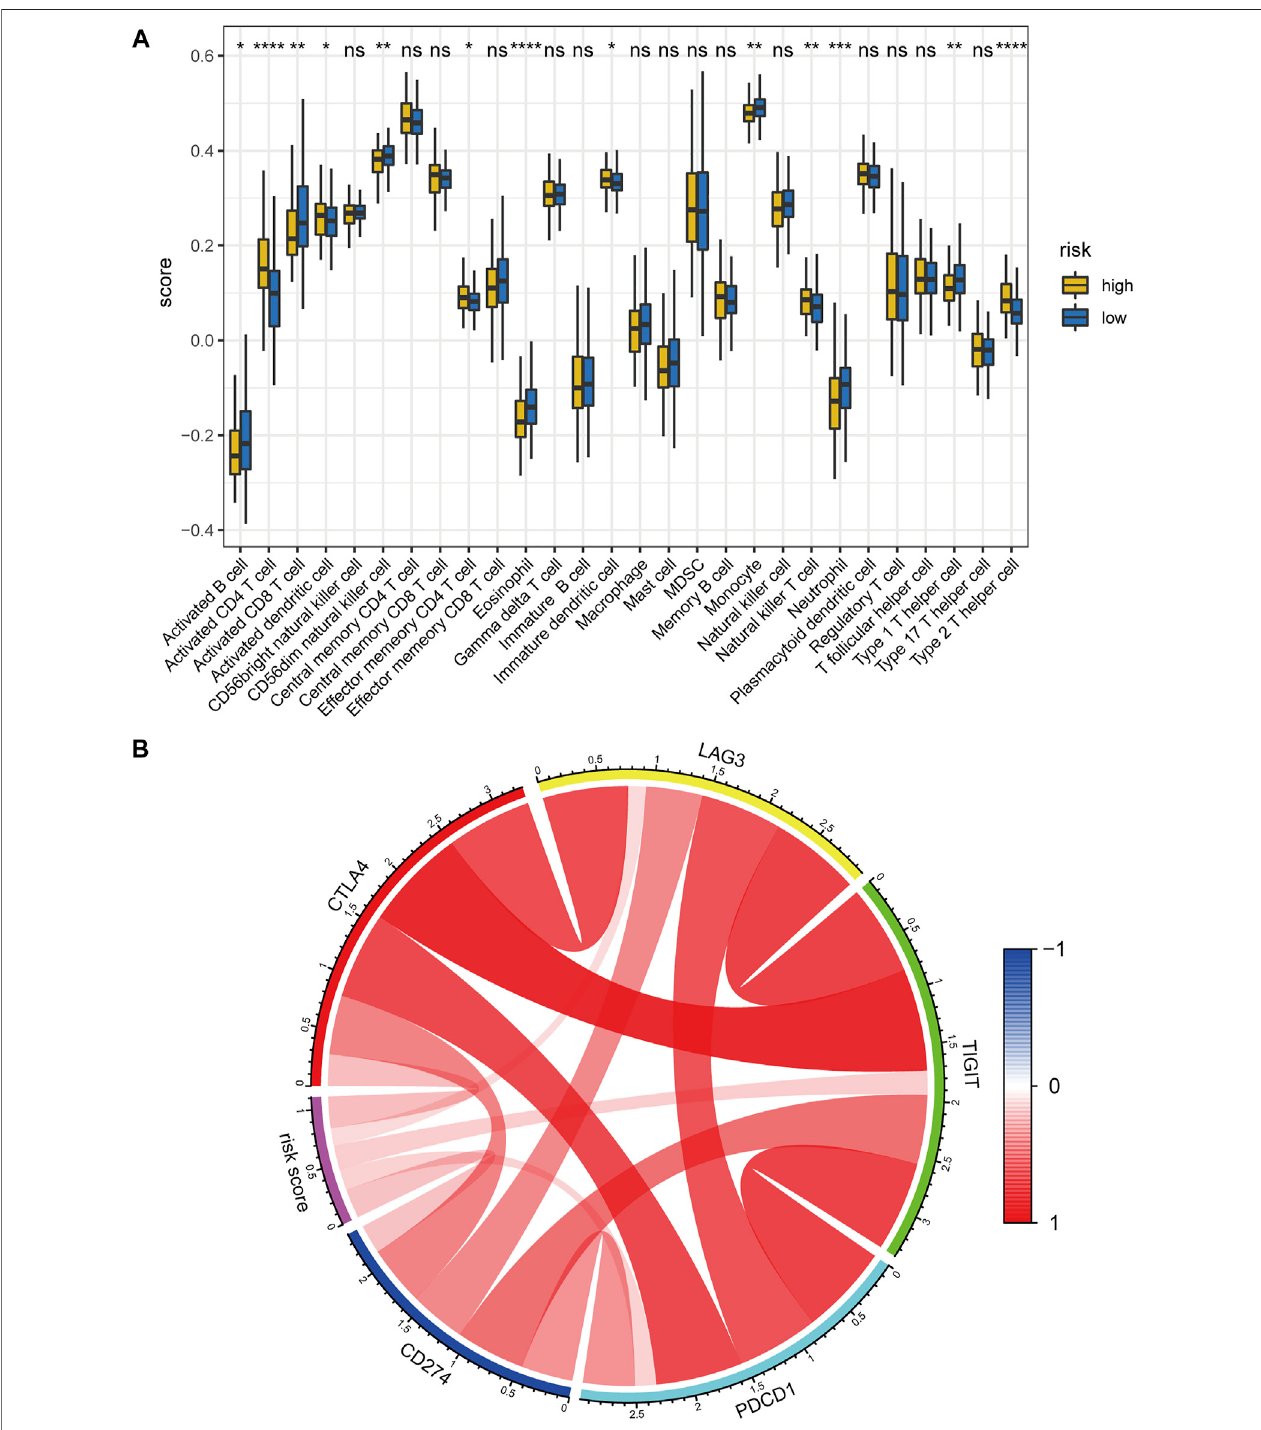
FIGURE 12 | Correlation between the hypoxia-related lncRNA signature and tumor immune microenvironment. (A) Comparisons of the abundance of 28 immune cells between the high- and low-risk group using ssGSEA. (B) Chord diagram of the correlation between hypoxia-related risk score and the expression levels of PD1(PDCD1), PDL1(CD274), CTLA4, LAG3, and TIGIT. The color red denotes the positive correlation and blue represents the negative correlation. ssGSEA: single- sample gene set enrichment analysis. ****, p < 0.0001; ***, p < 0.001; **, p < 0.01; *, p < 0.05; ns: no signi fi cance.